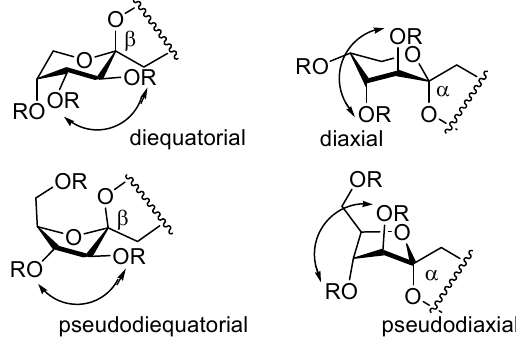
Figure 10 . Preferred conformations of the fructopyranose (top) and fructofuranose rings (down) in dispirodisaccharides. The relative disposition of the trans -oriented substituents at C-3 and C-4 is